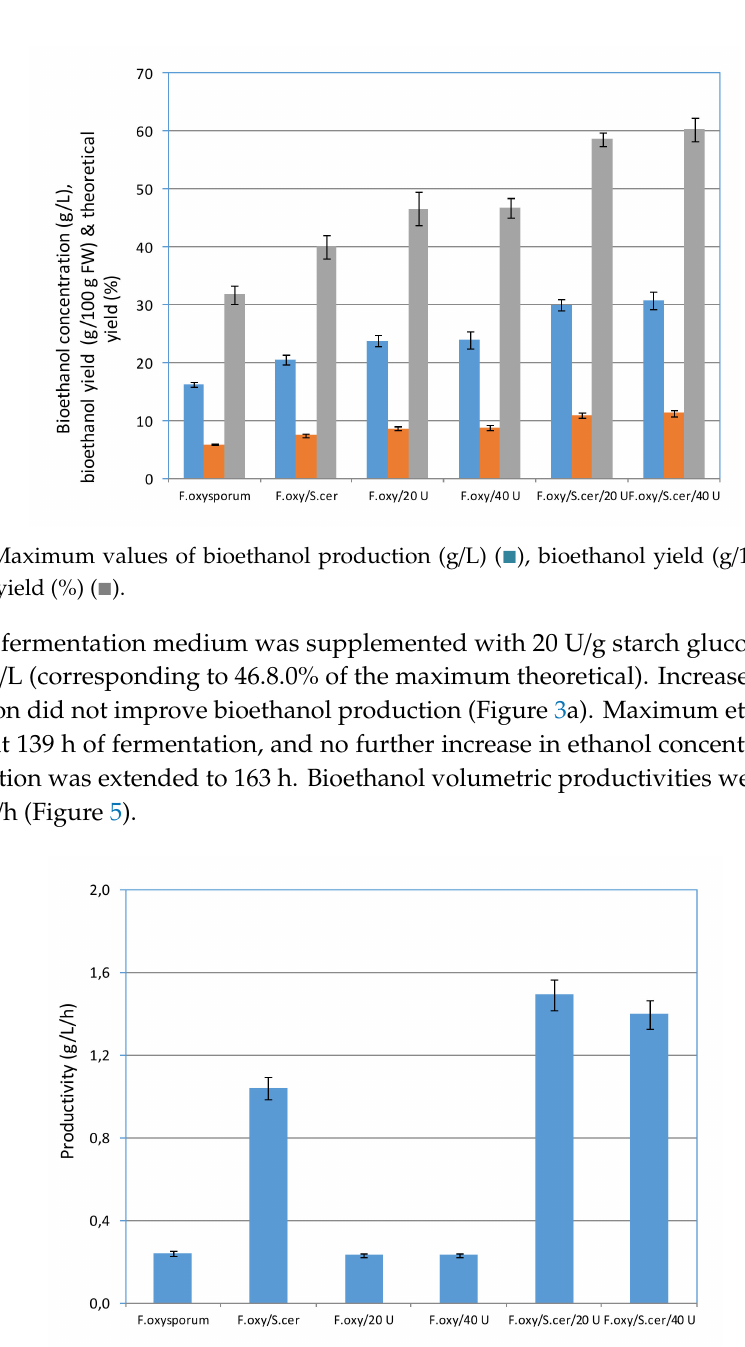
Figure 5. Bioethanol volumetric